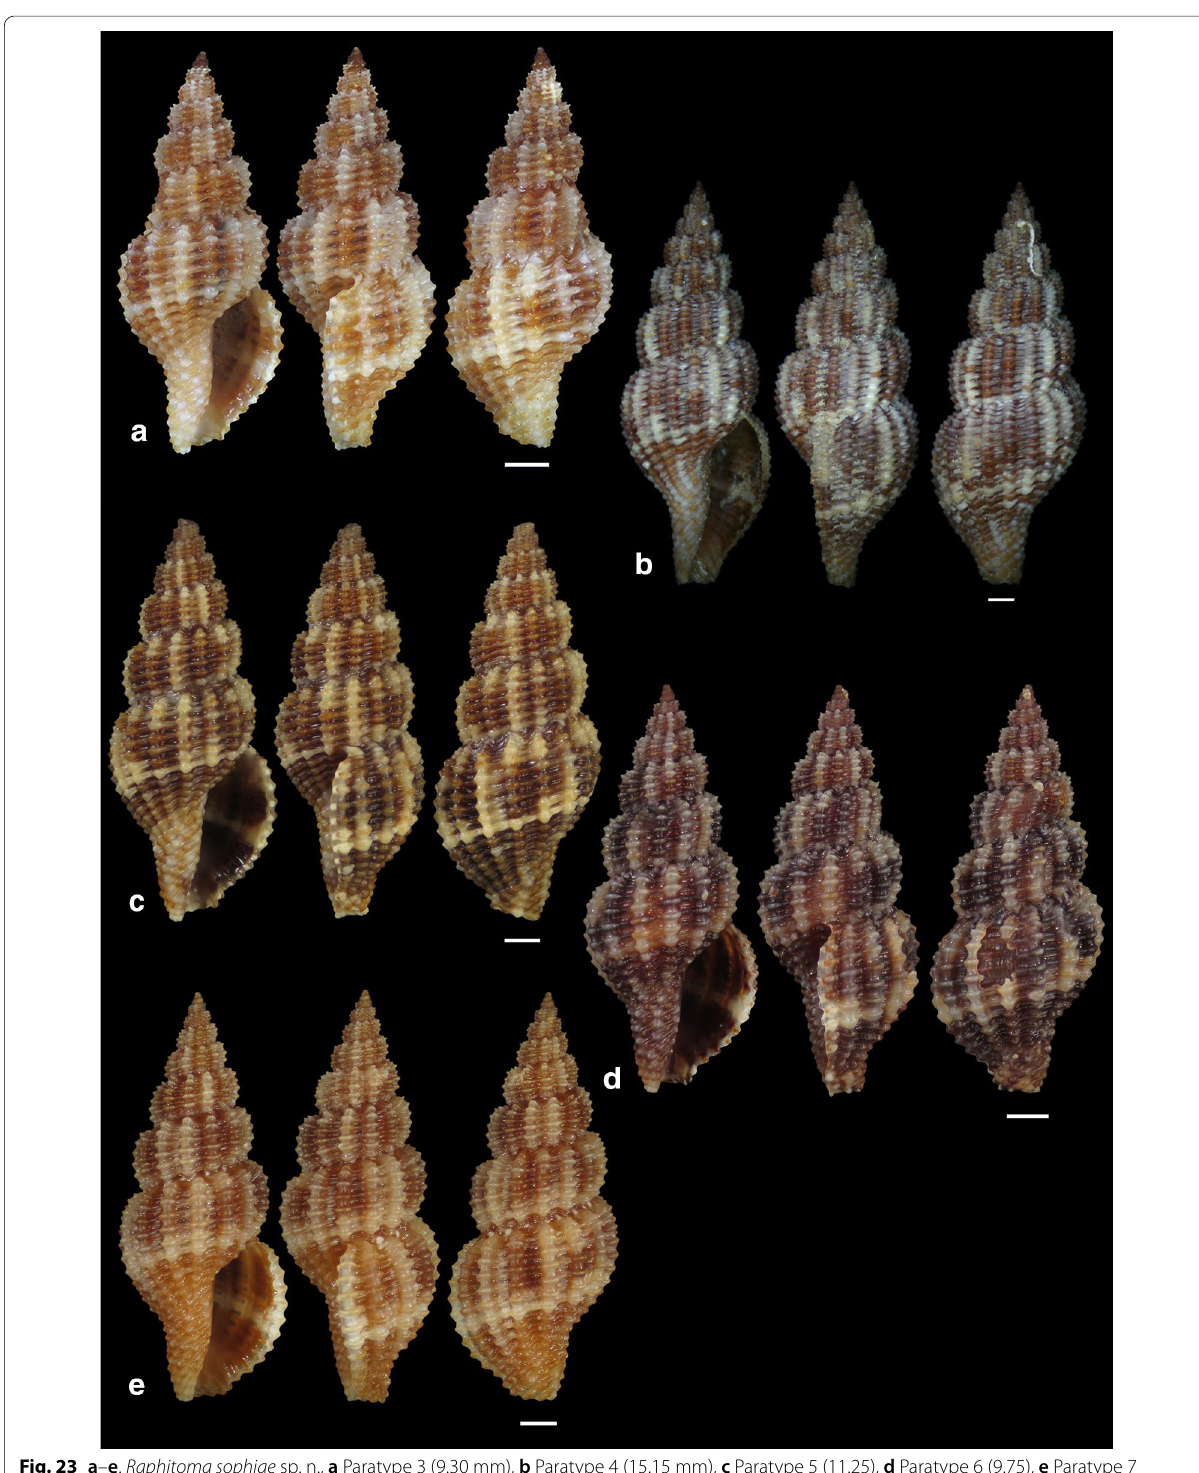
Fig. 23 a – e . Raphitoma sophiae sp. n., a Paratype 3 (9.30 mm), b Paratype 4 (15.15 mm), c Paratype 5 (11.25), d Paratype 6 (9.75), e Paratype 7 (11.30). Scale bar 1 =